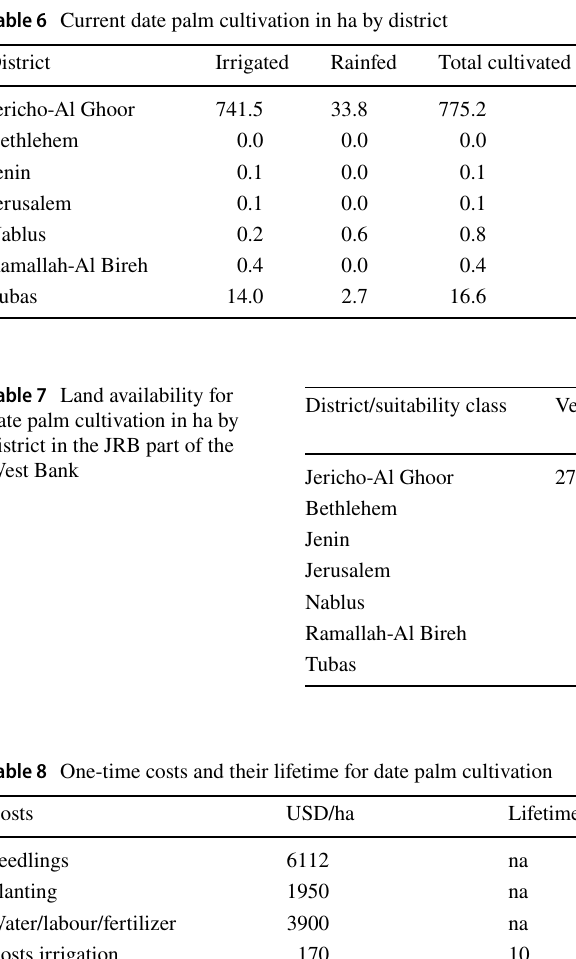
Table 6 Current date palm cultivation in ha by district District